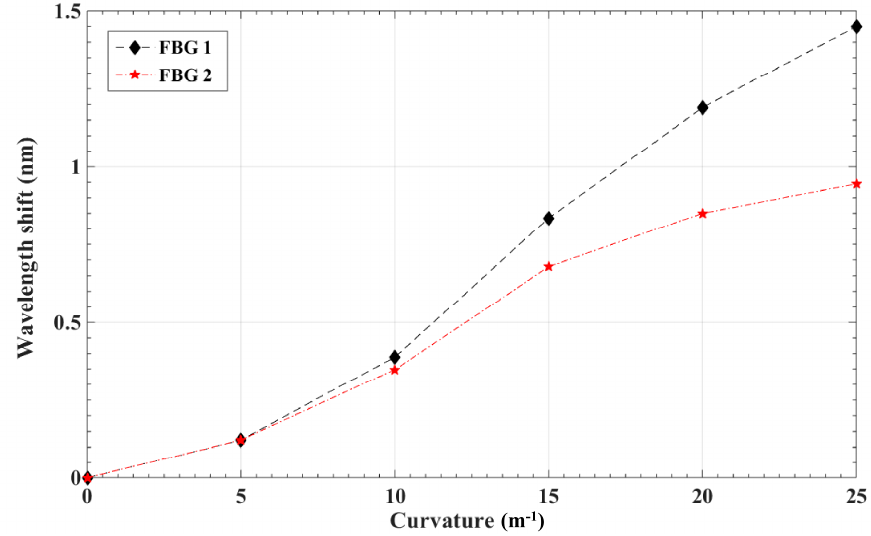
Figure 12. The wavelength shifts of two FBG sensors under different curvatures.